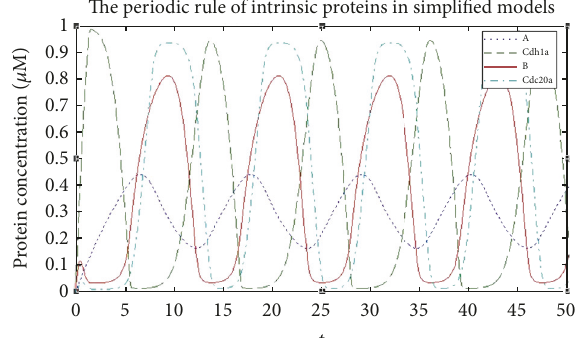
Figure 5: Periodicity of cyclin in the simplified system.